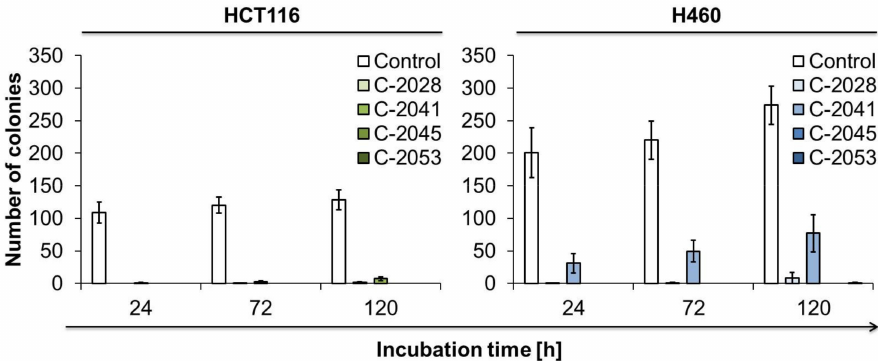
Figure 10. The ability of HCT116 and H460 cells to return to proliferation after UAs exposure. Cells were treated with 0.04, 0.05, 0.4 and 0.2 µ M of C-2028, C-2041, C-2045 and C-2053 compounds, respectively. After the indicated drug exposure, approximately 250 cells were cultured for two weeks in fresh medium, and the number of colonies was counted. Bar graphs show quantified data, expressed as the number of colonies ( n ≥